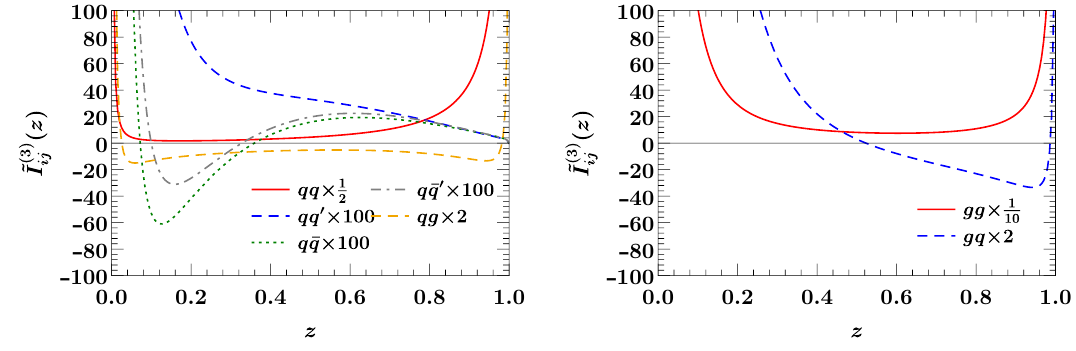
Figure 1 . The N 3 LO beam function boundary term ~ I (3) contributing to the quark beam function (left) and the gluon beam function (right). The di(cid:11)erent channels are rescaled as indicated in the